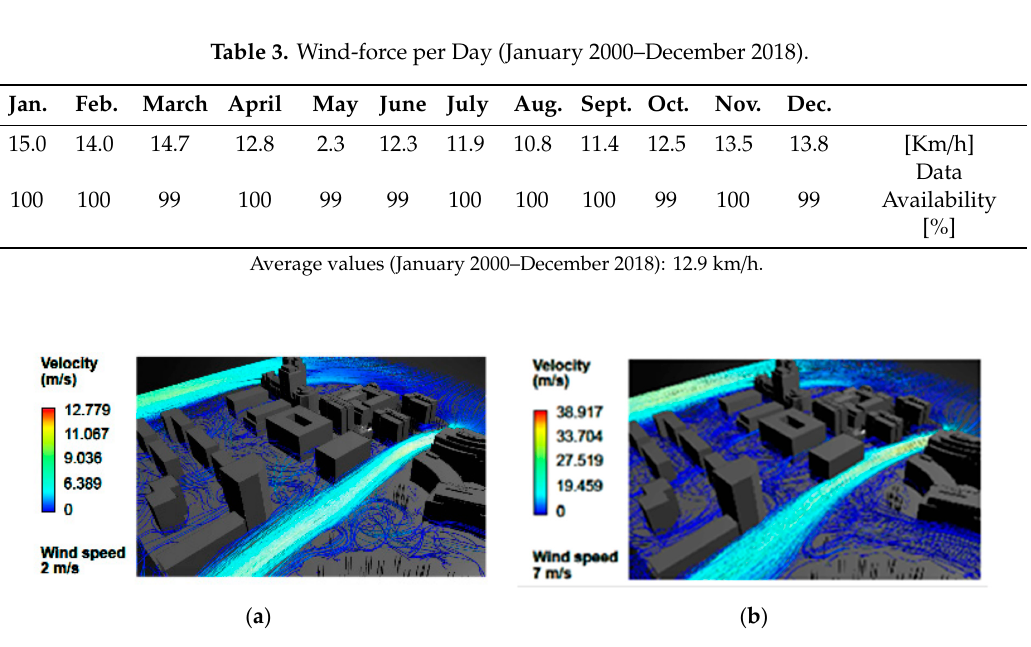
Table 3. Wind-force per Day (January 2000–December 2018).